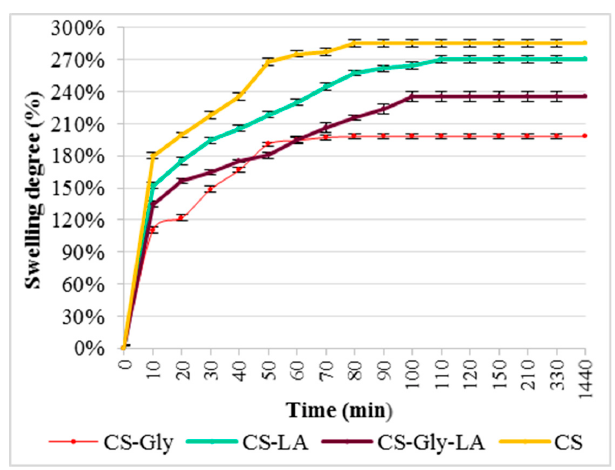
Figure 6. Swelling degree (%) in distilled water. Appl. Sci. 2020 , 10 , x FOR PEER REVIEW